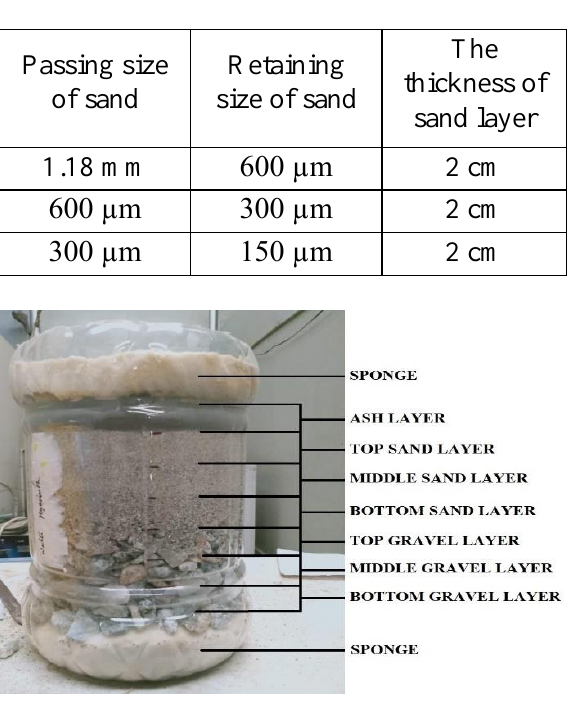
Figure 3. The arrangement of the filtering